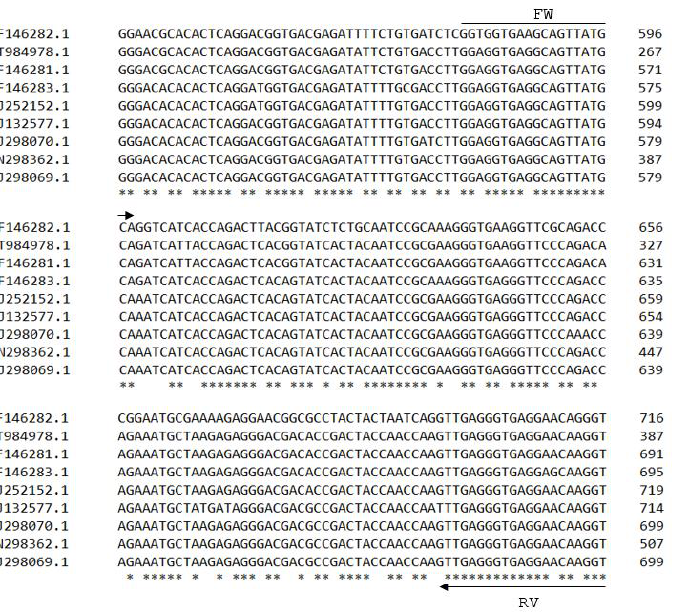
Figure 2. Sequence alignment of a portion of SBCMV RNA 2 of nine SBCMV isolates available in GenBank. Arrows indicate the position of primers designed for real-time PCR.